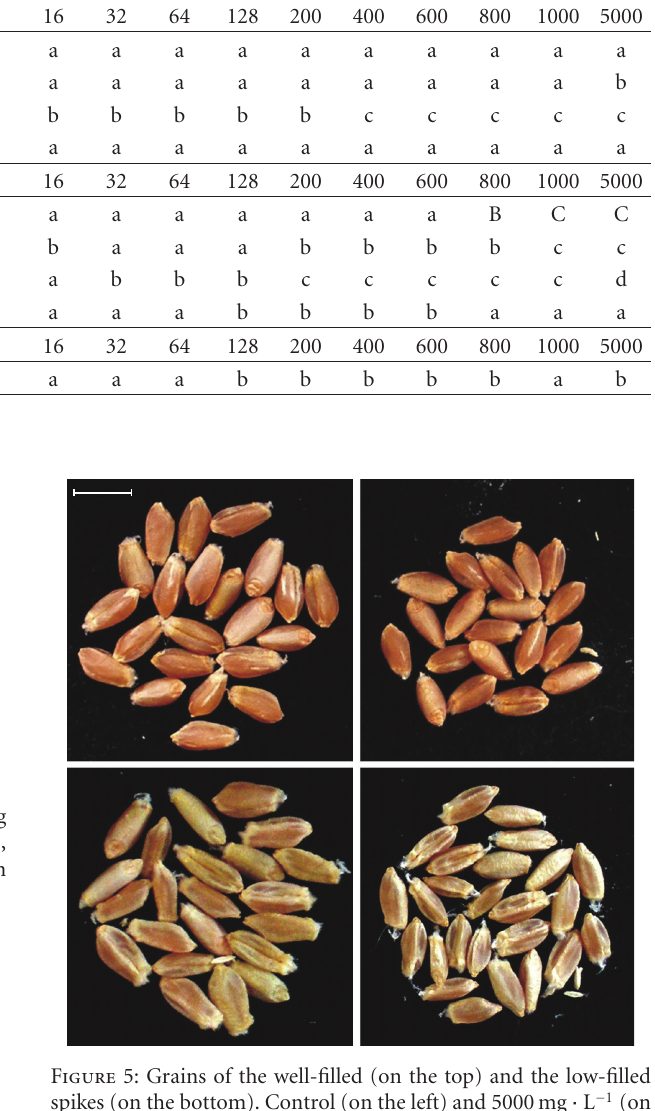
Table 1: Significance levels of the averages of the eight repeat experiments at LSD 005 in the well-filled (i) and in the low-filled (ii) groups and in case of the total yield per plants (iii) according to one-way analysis of variance (one-way ANOVA).